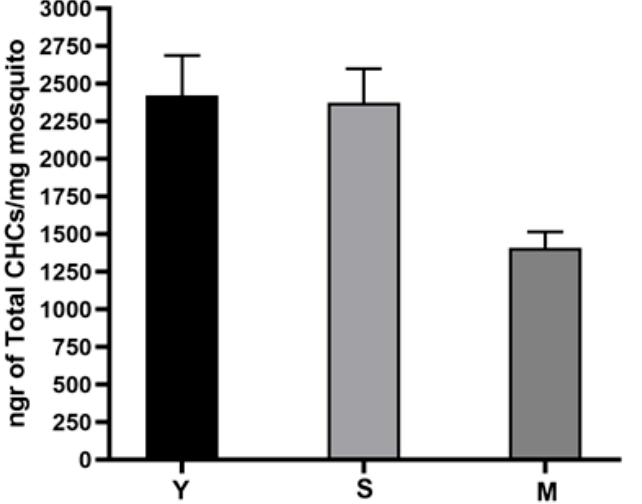
Figure 2. Mean cuticular hydrocarbon (CHC) amounts from three Anopheles mosquito populations. Yangah (Y) and Simatou (S) An. pharoensis have significantly higher amounts of CHCs compared to Maga (M) mosquitoes normalized for their size differences (two-tailed t -test, p value < 0.05).